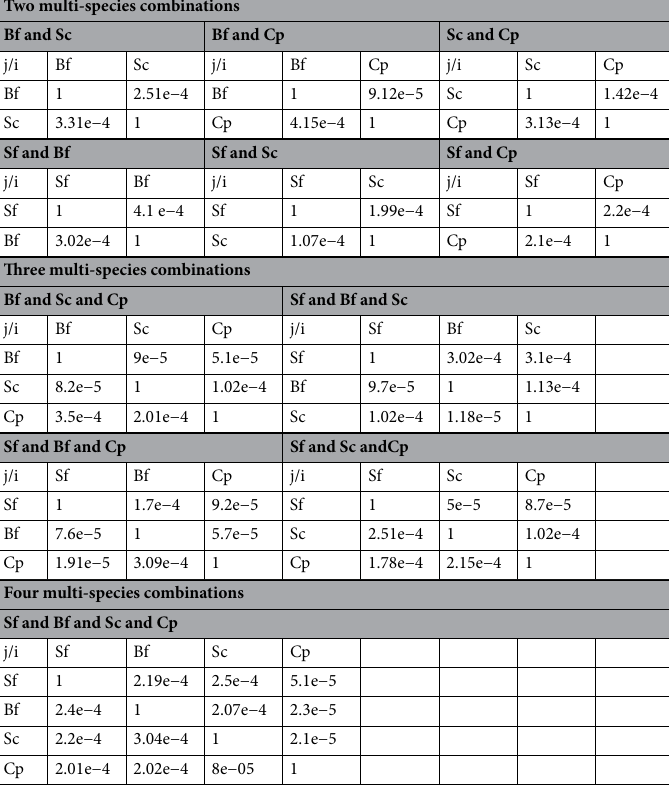
Table 1. Vice versa competition coefficients of two, three and four multi-species systems. Bf, Busseola fusca ; Cp, Chilo partellus ; Sc, Sesamia calamistis ; Sf, Spodoptera